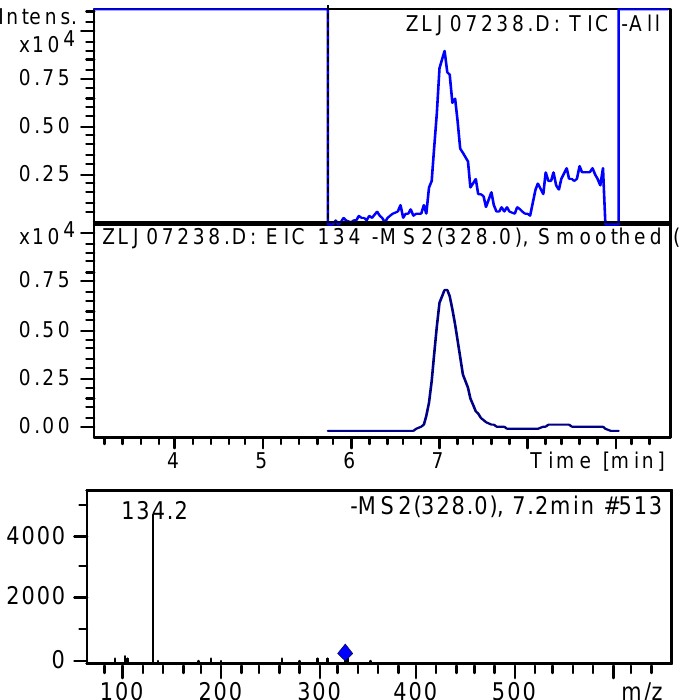
Figure 8 . Typical chromatogram of 100 pmol/ml 3´,5´-cAMP with HPLC-MS EIC